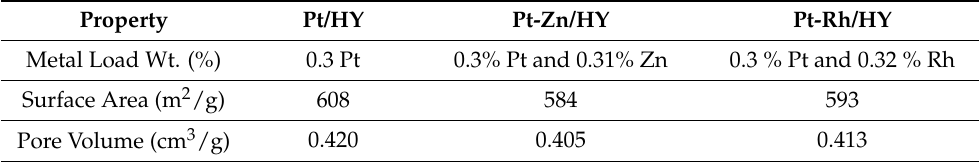
Table 4. Total surface area and pore volume of the prepared nanocatalysts.